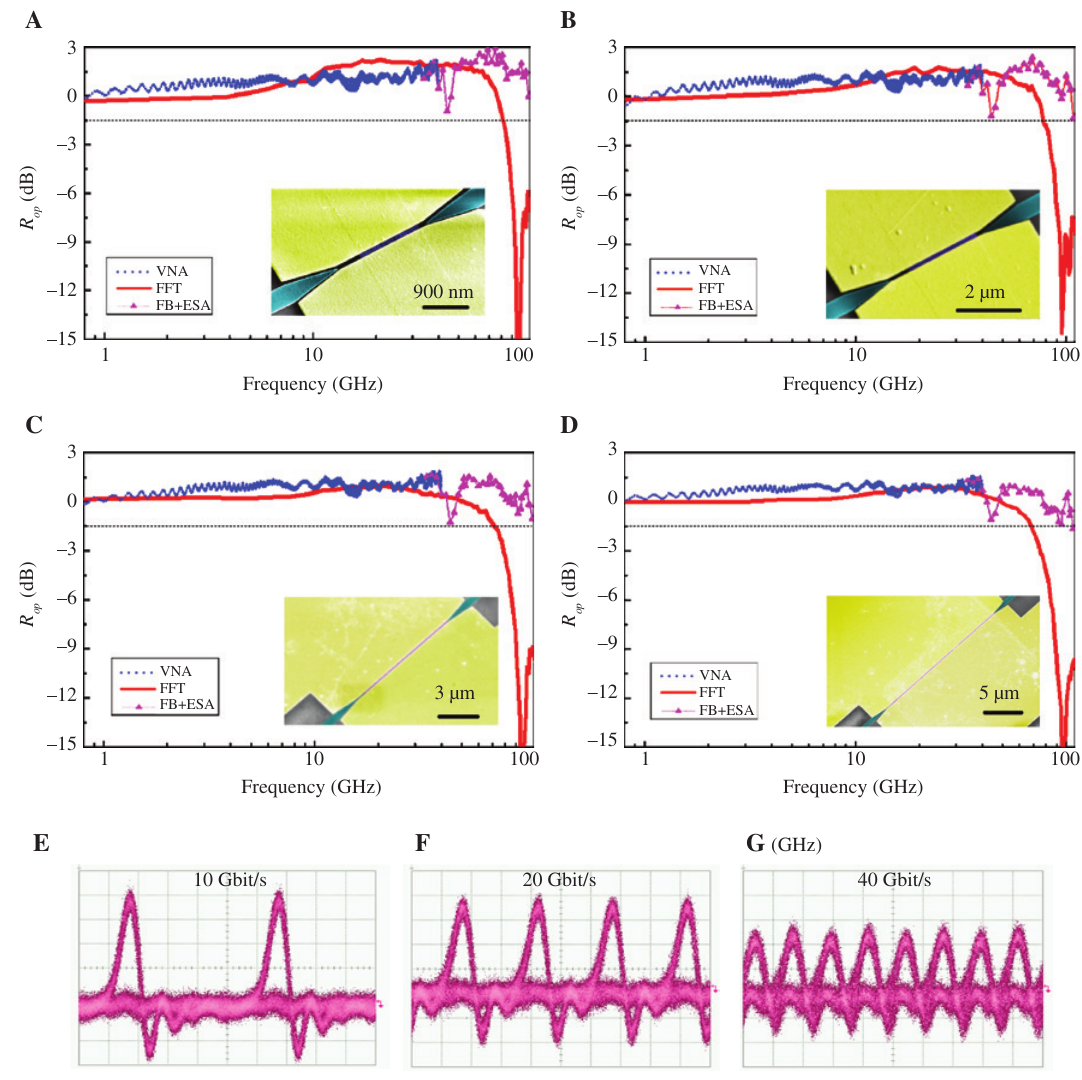
Figure 4: Bandwidth characterization of the devices. (A–D) Measured optical bandwidth by VNA, impulse response, and frequency beating with ESA for the devices with graphene coverage lengths of 2.7, 3.5, 9, and 19 μ m, respectively, at the bias voltage of 1.6 V. The insets show the SEM images of associated fabricated devices. (E–G) Measured eye diagram of the RZ optical signal at 10, 20, and 40 Gbit/s, respectively, for the device with 19 μ m graphene coverage length and biased at 1.6